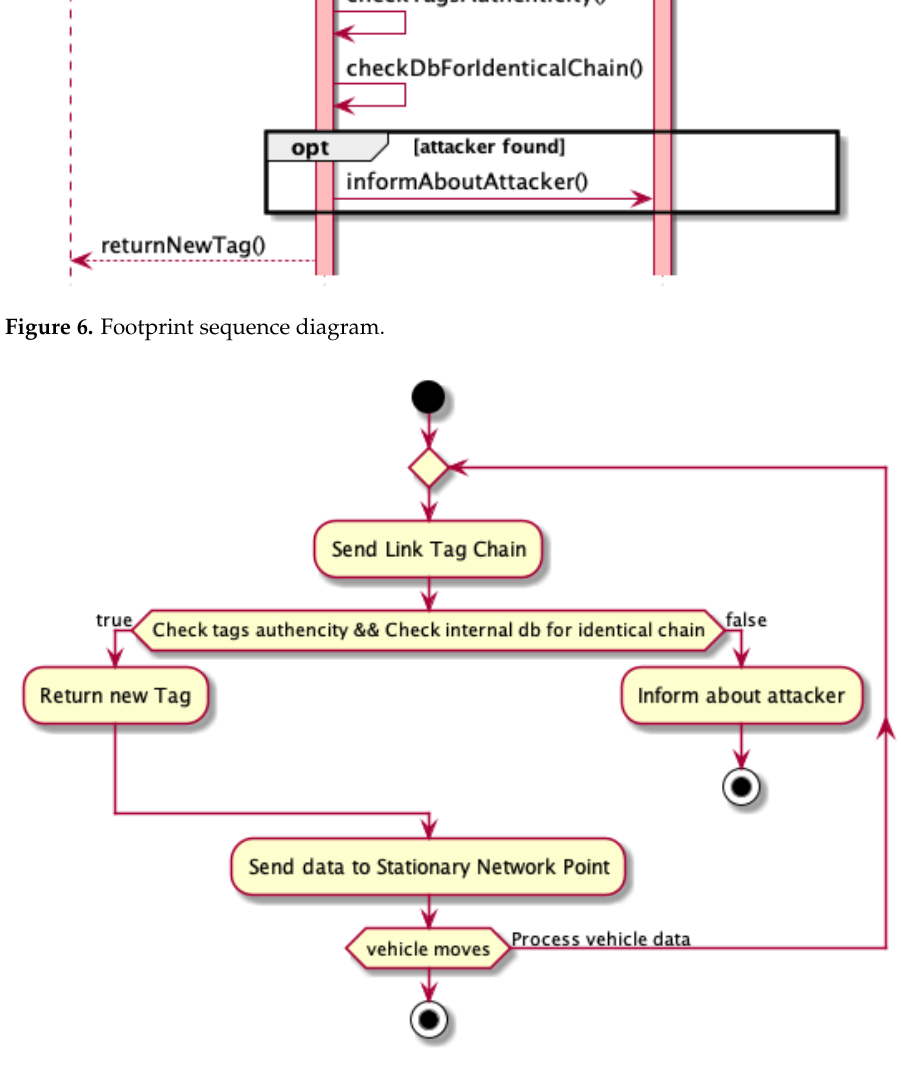
Figure 7. Footprint activity